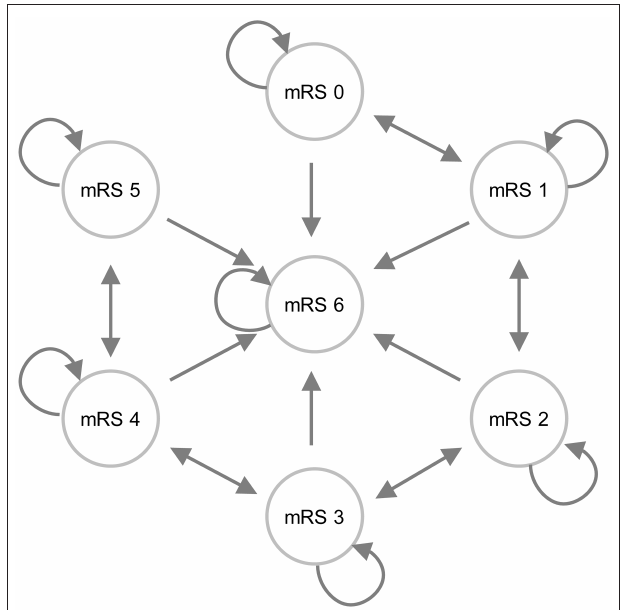
FIGURE 1 | An influence diagram of the state transition model. Patients could enter the model via one of the mRS score health states. The arrows indicate the most likely transitions during follow-up; however, it was also possible to improve from mRS 3 to mRS 1, for example.